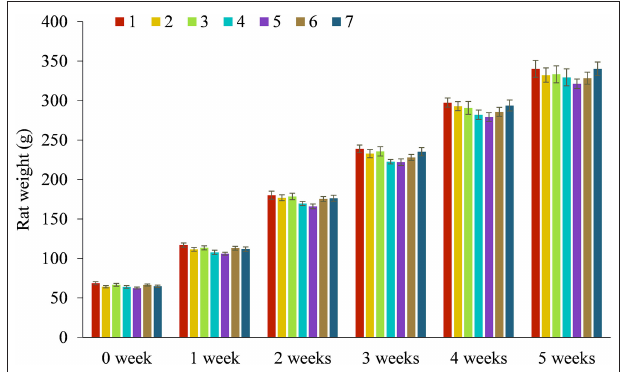
FIGURE 1 | Effect of body weight trends in SD rats treated with groups 1–7 in five consecutive weeks, n = 8 per each group. 1: Blank control, 2: former type, 3: new-L, 4: new-M, 5: new-H, 6: new-C, 7: